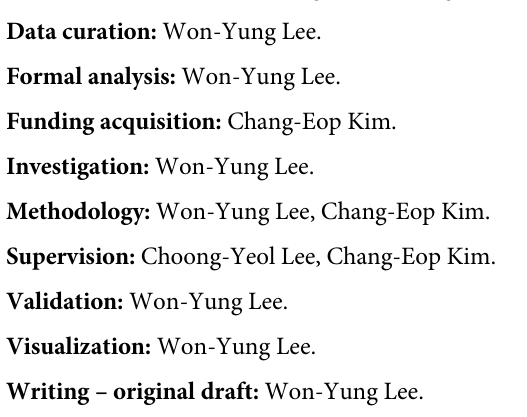
S3 Table. Performance comparison between joint learning and AI-DTI. S4 Table. Candidate FDA-approved drugs for COVID-19-related activatory targets. S5 Table. Candidate FDA-approved drugs for COVID-19-related inhibitory targets. S1 Fig. The architecture and hyperparameters of the MLP models. S2 Fig. Distribution of spearman correlation coefficients between the inferred data and genetically perturbed transcriptome for the same gene (Within pair) and the other genes (Between pair). S3 Fig. Predictive performance of AI-DTI on DTIs between FDA-approved drugs and COVID-19-related